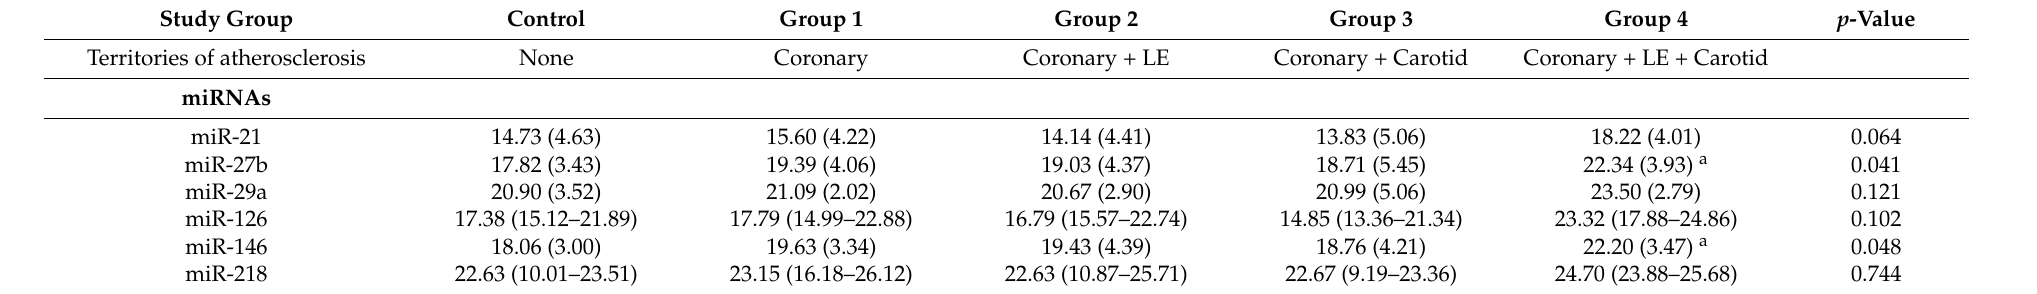
Table 2. Expression of circulating miRNAs according to the involved territories of